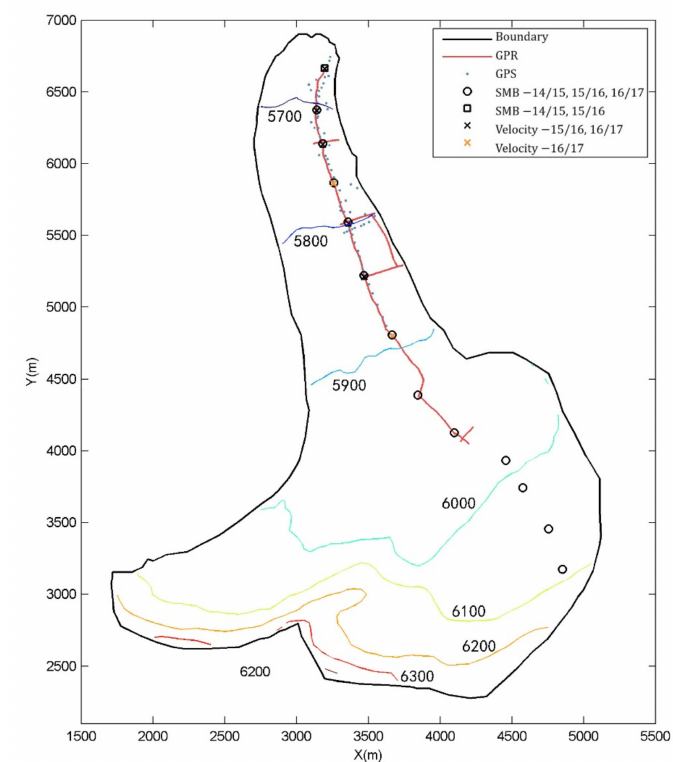
Figure 4. The glacier, with the outline marked in black. Ground Penetrating Radar (GPR) measure- ments are shown as the red track in the lower glacier and differential GPS measurement as blue points. Stakes are marked as black squares for SMB measured over 2 years (2014/2015, 2015/2016) and black circles for SMB measured for 3 years (2014/2015, 2015/2016, 2016/2017). Stakes are marked by black crosses for velocity measured in 2015/2016 and 2016/2017, and by orange crosses for velocity measured only between 2016 and 2017. Surface elevation contours in the year 2016 (Section 5). Recent Equilibrium Line Altitudes (ELA) from the year 2014 to 2017 are around 5900 m.